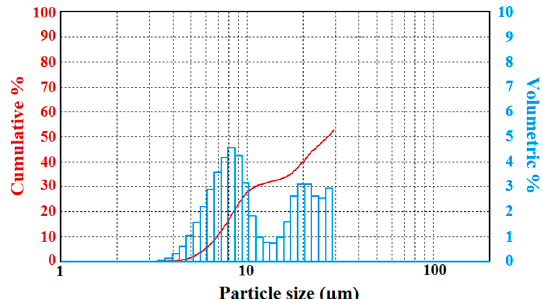
Figure 5. Averaged fog droplet spectrum below 30 µ m were obtained for the pure distilled water case